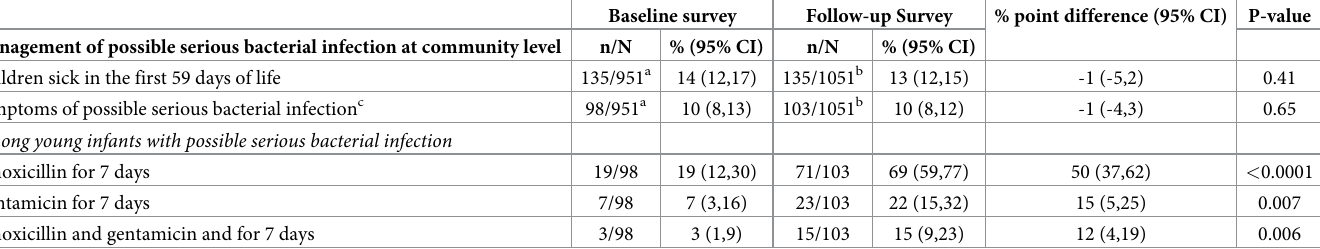
Table 5. Treatment of sick young infants reported by mothers who had a birth in the 3–15 months prior to the baseline (October–December 2013) and follow-up (November-December 2017)